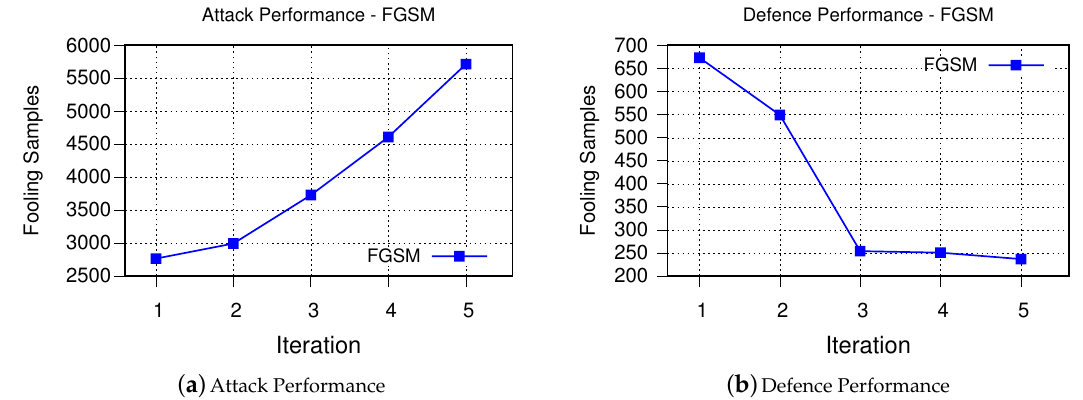
Figure 6. The results of